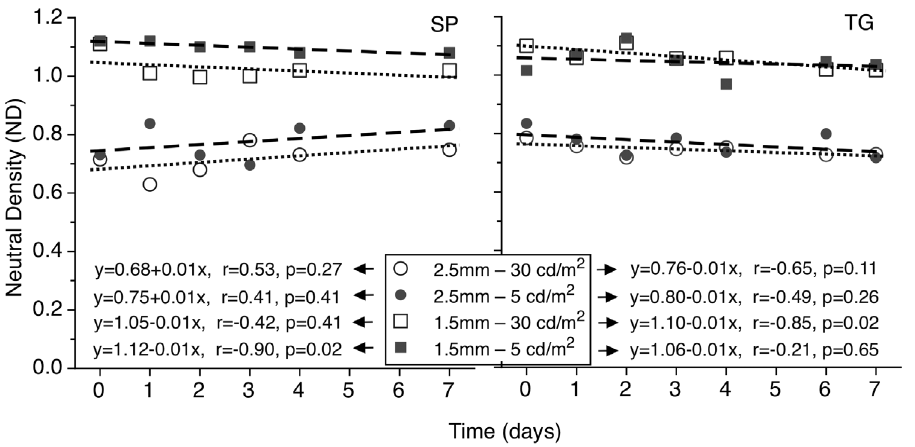
Figure 4. Values of ND filter required to null the Pulfrich effect as a function of time. The non-dominant eye was wearing a 2.5 mm (circles) or a 1.5 mm lens (squares). Data for subject SP (left) and TG (right) at high (open symbols) and low (filled symbols) photopic levels are presented. The average values of ND filter required to null the Pulfrich effect, when placed in front of the dominant eye, for all conditions are also shown. The dotted / dashed lines form a linear regressions for Days 0 to 7.